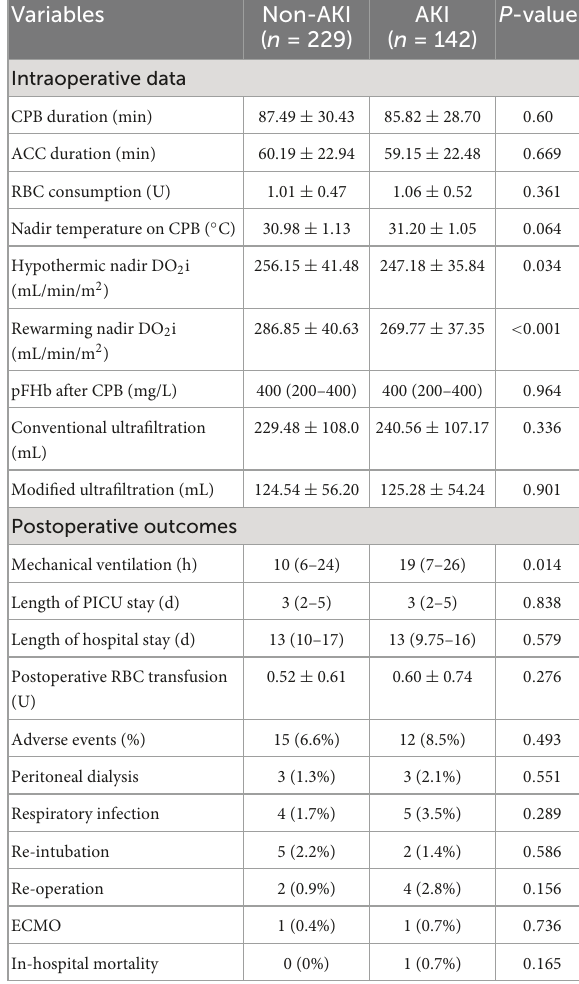
TABLE 2 Intraoperative data and clinical